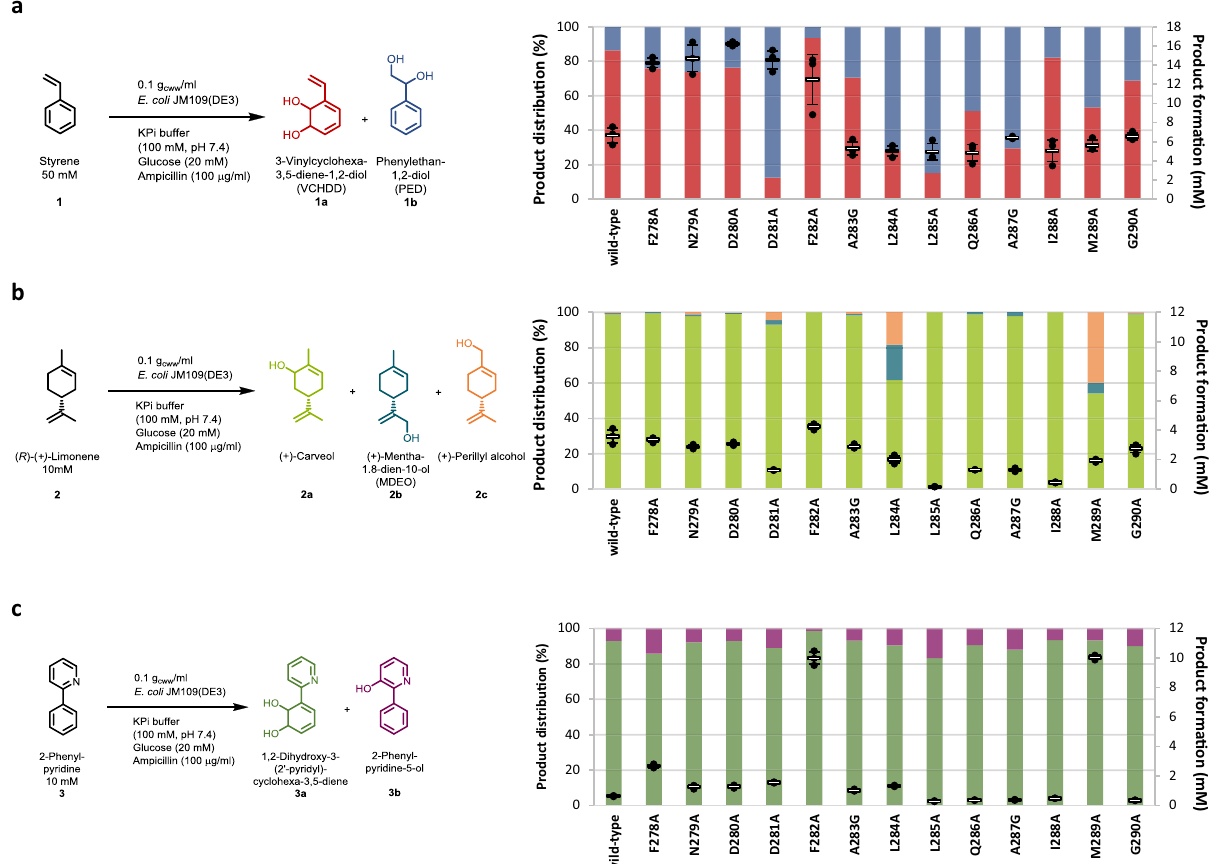
Fig. 2 Biotransformations with the wild-type and alanine variants of loop 2. a Product formation and distribution of the products 3-vinylcyclohexa-3,5- diene-1,2-diol 1a (VCHDD, red, bottom bars) and phenylethan-1,2-diol 1b (PED, blue, top bars) obtained during the biotransformation of styrene 1 . b Product formation and distribution of the products ( + )-carveol 2a (green, bottom bars), ( + )-mentha-1.8-dien-10-ol 2b (MDEO, blue, middle bars) and ( + )-perillyl alcohol 2c (orange, top bars) obtained during the biotransformation of ( R )-( + )-limonene 2 . c Product formation and distribution of the products 1,2-dihydroxy-3-(2 ’ -pyridyl) cyclohexa-3,5-diene 3a (green, bottom bars) and 2-phenylpyridine-5-ol 3b (purple, top bars) obtained during the biotransformation of 2-phenylpyridine 3 . Reaction conditions and substrate concentrations are indicated in the reaction equation. The reactions were performed in technical triplicates (black dots) with average values (horizontal bar) and standard deviations (calculated using Excel version 2016) indicated. Error bars may be covered by markers. Source data are provided as a Source Data fi